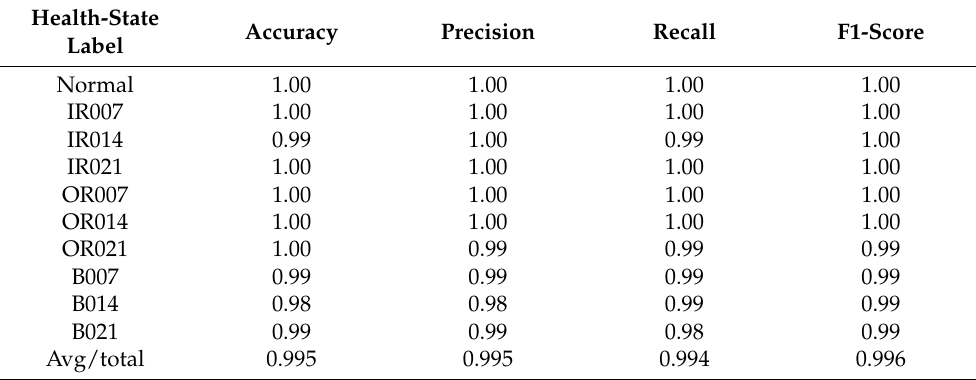
Table 3. The values of evaluation indicators under different working